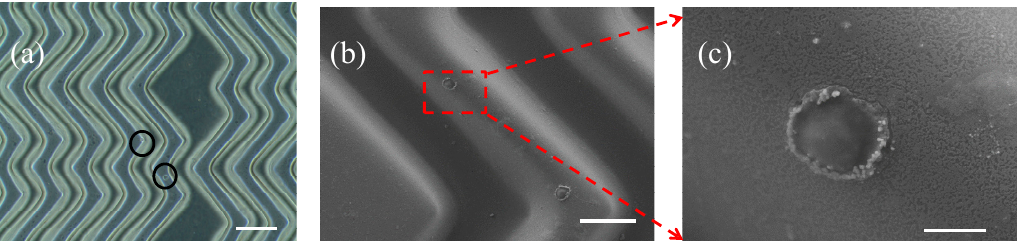
Figure 6. ( a ) Microscopic image of captured cancer cells on the hierarchical wavy-HB pattern. Scale bar: 160 µ m. ( b ) SEM image of captured cancer cells on the pattern. Scale bar: 50 µ m. ( c ) A zoom-in image reveals details of the interaction between a cancer cell and the NPs covered wavy pattern. Scale bar: 8 μ m.